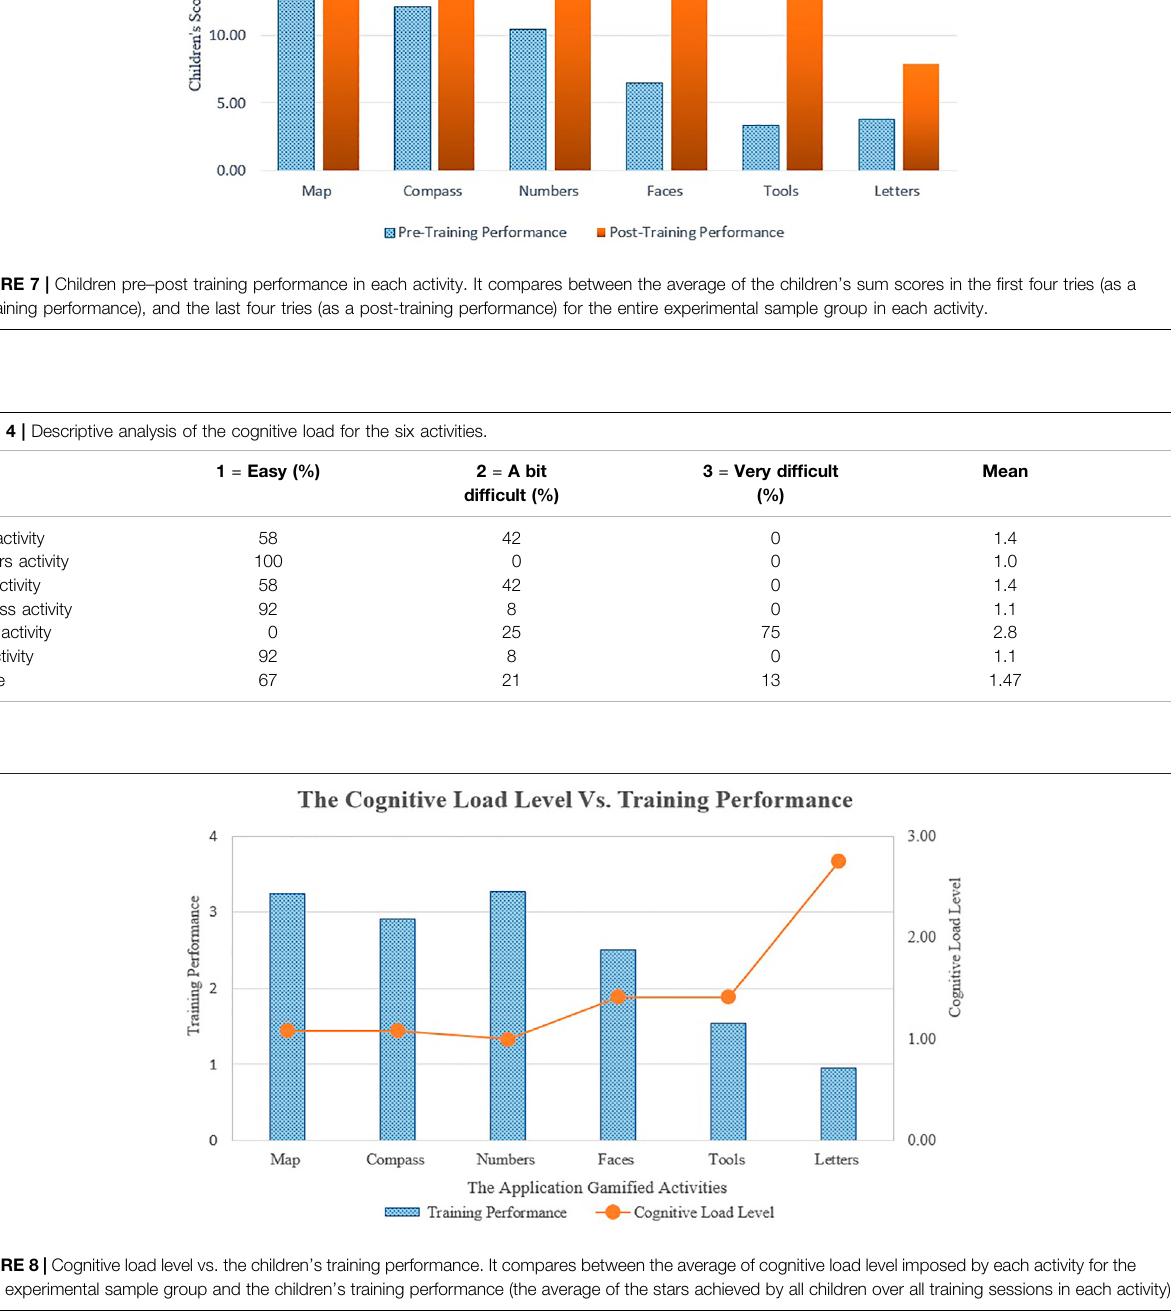
Frontiers in Computer Science |